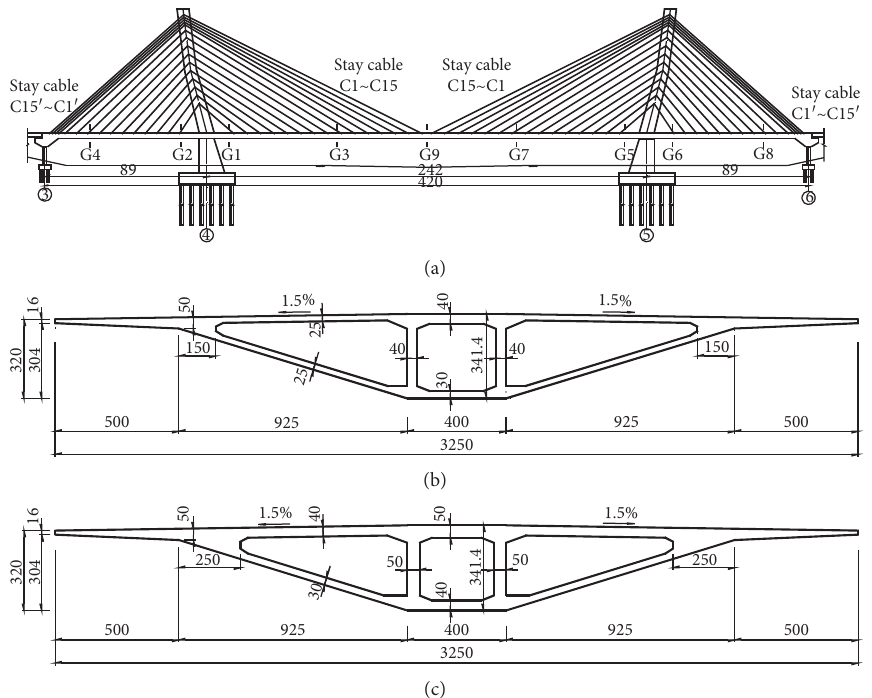
Figure 1: Structural drawing of bridge (unit: cm). (a) Schematic of main bridge. (b) Cross section of mid-span girder. (c) Cross section of side-span